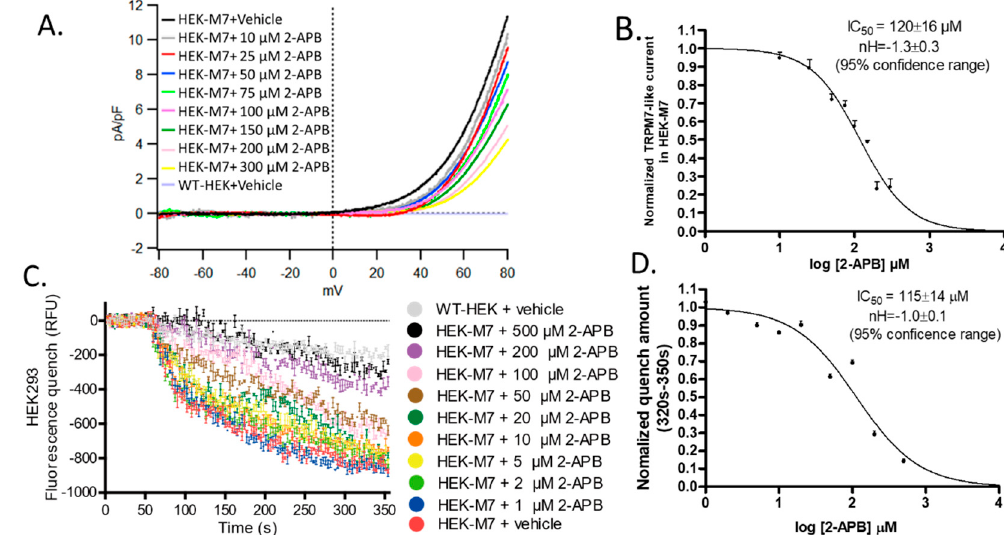
Figure 2. E ff ect of 2-APB on TRPM7 channels. ( A ) Representative TRPM7-like current from a whole-cell patch-clamp experiment with a HEK-M7 cell. The voltage was clamped at − 80 mV, then ramped from − 80 to + 80 mV. The outwardly rectifying current at positive potentials was suppressed by a perfusion solution containing 2-APB and completely reversed by perfusion with a 2-APB-free solution. There was a very low rectifying current (2.2 fA / pF at + 80 mV) in the WT-HEK cells (Figure S1). ( B ) Normalized current at + 80 mV ( n ≥ 5). The IC 50 and Hill slope of the current blockade by 2-APB were 120 ± 16 µ M and − 1.3 ± 0.3, respectively (95% confidence range). ( C ) Results from experiments using Mn 2 + quenching of Fura-2AM fluorescence. Mn 2 + and 2-APB were added after 50 s baseline measurement. 2-APB suppressed fluorescence quenching by blocking entry of Mn 2 + via TRPM7 channels. Fluorescence quenching in WT-HEK cells may reflect the flux of Mn 2 + through pathways other than TRPM7 channels. ( D ) Normalized quench levels averaged over 320–350 s ( n = 3). The IC 50 and Hill slope of quench blockade was 115 ± 14 µ M and − 1.0 ± 0.1, respectively (95% confidence